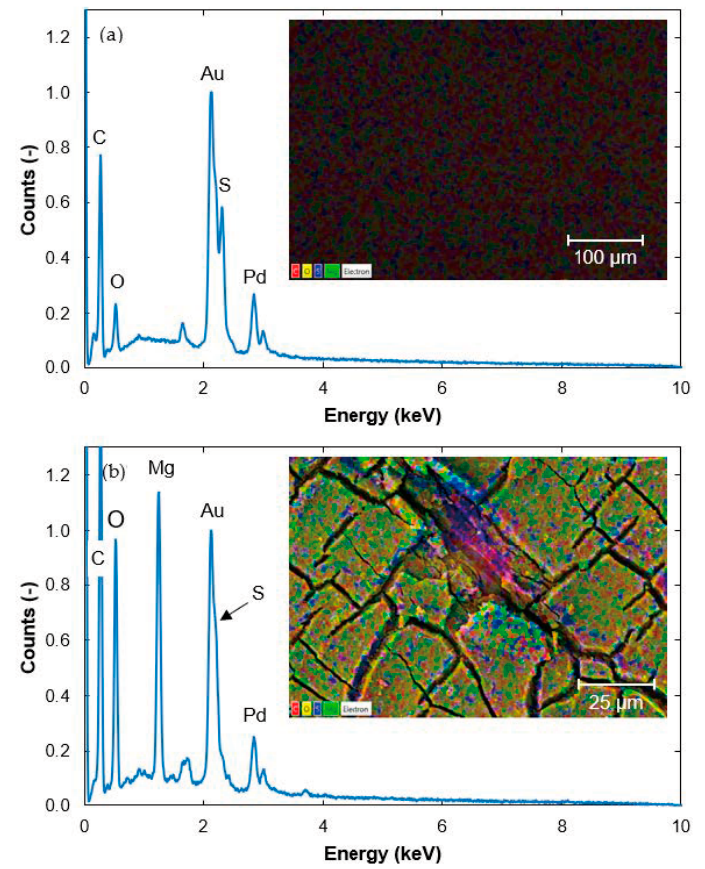
Figure 2. Energy dispersive X-ray spectrometry (EDS) spectra from: ( a ) a pristine membrane and ( b ) a fouled membrane. Scanning electron microscopy (SEM) images of the membrane surface are shown in the inserts. Colors in the images indicate carbon (red), oxygen (yellow), sulfur (blue) and magnesium (green). The values on the y -axis are normalized to the value of the Au peak at 2.13